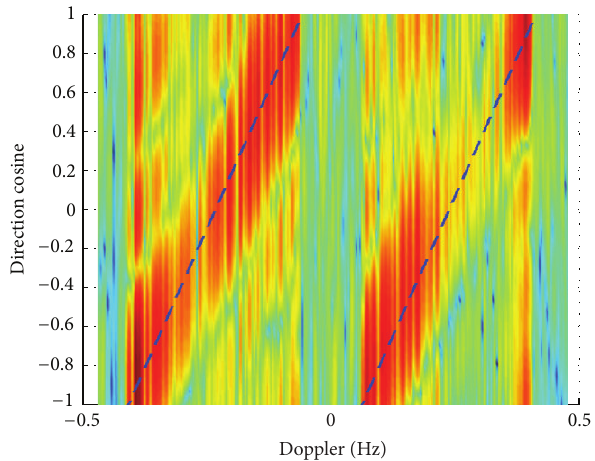
Figure 6: Space-time spectrum of real data processed by DFT and DBF cascaded processing. – – denotes the theoretical value ( 𝑓 0 = = 0.262 s, 𝑑 = 14 m). 5.283 MHz, 𝑇 𝑝